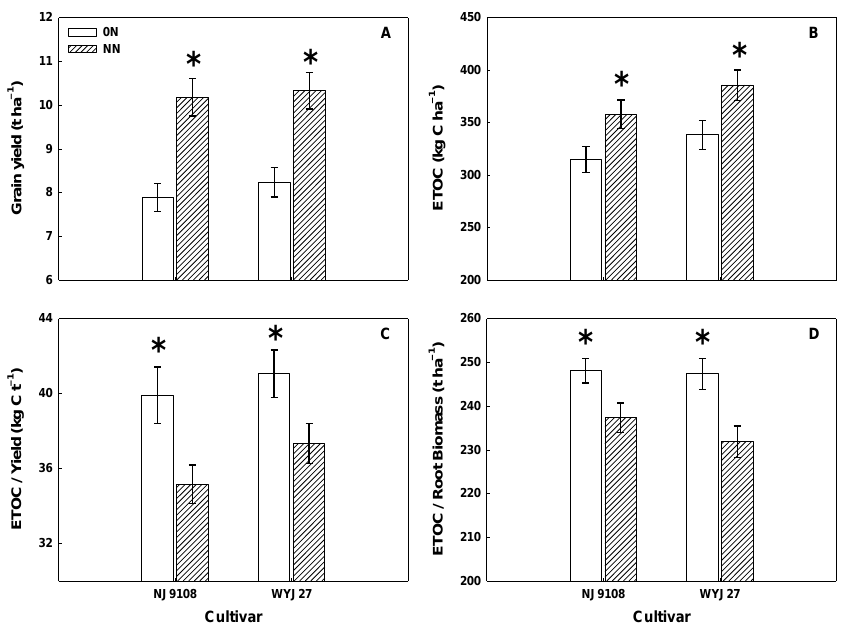
Figure 7. Effect of nitrogen application at panicle differentiation stage on grain yield ( A ), total or- ganic carbon in root exudation ( B ), as well as the ratio of total organic carbon in root exudation to yield ( C ) and root biomass ( D ). 0N: no nitrogen application; NN: nitrogen application rate at 120 kg ha −1 . * indicates statistical significance within the same rice cultivar at p < 0.05 level. 4. Discussion 4.1. The Effect of CR on Rice Yields In the past 60 years, the grain yield of rice in China has increased threefold, which could be attributed to the CR, improved crop management practices such as N fertilizer application, and plant protection practices [4]. Some studies showed that the contribution of CR and crop management to yield increase reached 38.9 – 61.7% and 9.3 – 16%, respec- tively [28,29]. Since the 1990s, the N fertilizer input has reduced, but the grain yield of rice is still increasing, suggesting that the CR rather than N fertilizer is the main factor influ- encing the yield increase in rice in recent 20 years [30,31]. The increasing atmospheric CO 2 concentration also showed a fertilizer effect on rice growth since it acted as the substrate